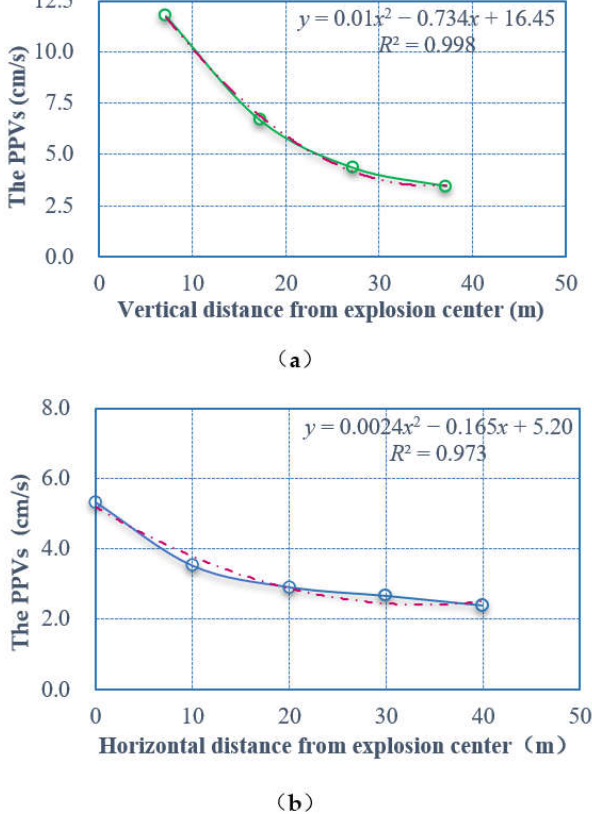
Figure 10. The relationship between PPVs and distance from blasting center: ( a ) the PPV evolution law at different vertical depths; ( b ) the PPV evolution law at different horizontal distances on the surface. The relationships between the PPVs and the vertical distance H and the horizontal distance L from the explosion center are as follows: